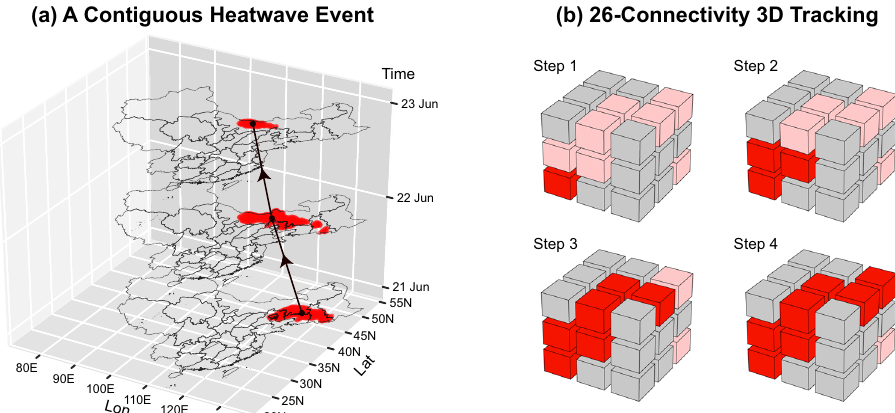
Fig. 1 Example and illustration of the spatiotemporally contiguous events tracking. a An example of a contiguous heatwave event that propagated eastward from 21 June to 23 June 1961, with black dots marking the intensity-weighted centroid throughout all participating days of the event. b An illustration of the 3D tracking of spatiotemporally contiguous heatwaves. Pink cell indicates that there is a heatwave day, while gray indicates not. The tracking process in b starts with the lower-left red cell in Step 1, and it searches the connected heatwave day in neighboring pink cells (Steps 2 – 4). It keeps searching until all connected cells are assigned to a contiguous event (Step 4). Table 1. Summary of the metrics used in this study to characterize spatiotemporally contiguous heatwaves. Category